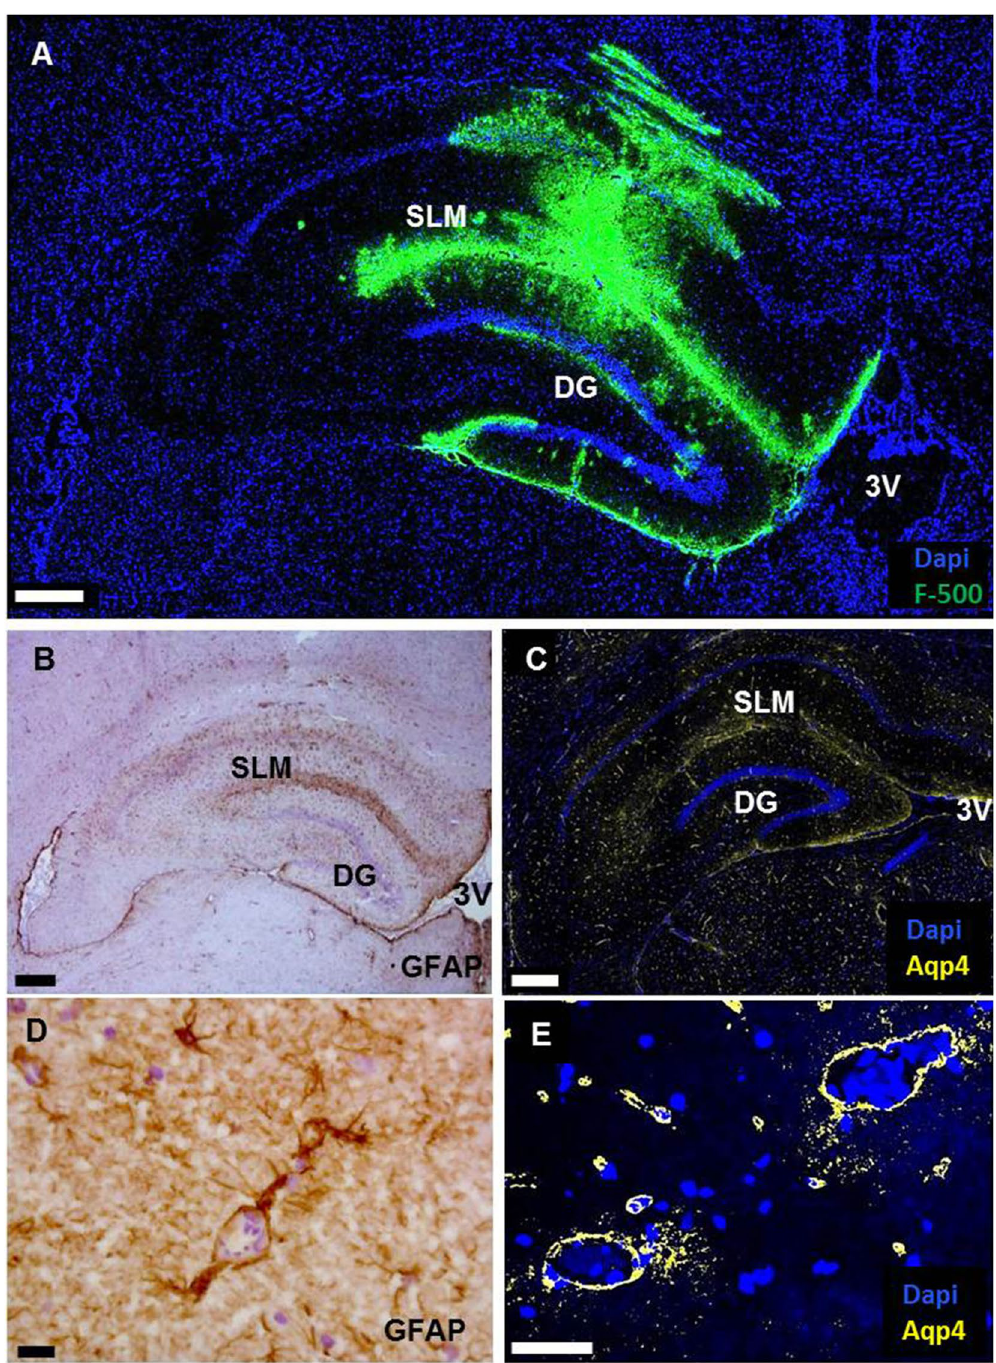
Figure 5. Co-localization of tracer accumulation with GFAP and aquaporin 4 staining. Panel A: High molecular weight tracer (green) distribution after infusion in the hippocampus of a WKY. Tracer accumulates along the stratum lacunosum molecolare (SLM) and at the boundaries of the hippocampus. Panel B: Expression of the astrocyte marker GFAP. Panel C: Expression of aquaporin 4. Tracer, GFAP and Aqp4 colocalize at the suprapyramidal and infrapyramidal blades of the dentate gyrus and the ependyma layer at the third ventricle. DG: dentate gyrus. 3 V: third ventricle. Scale bar in A–C 400 µ m. Panels D and E show a close up of the vessels present at the SLM region. Both GFAP and Aqp4 are expressed around vessels. Scale bar in D = 15 μ m, E = 50 μ